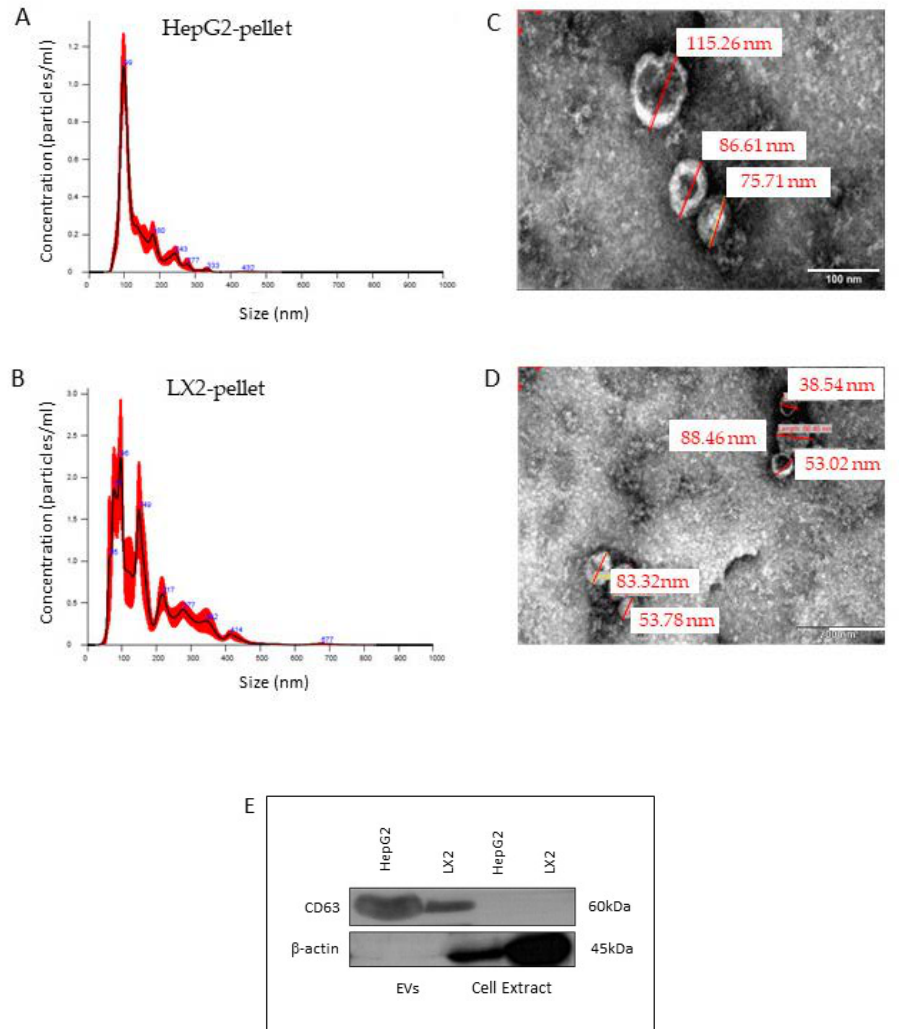
Figure 4. Characterization of LX2- and HepG2-primed medium pellets. Representative nanoparticle tracking analysis (NTA) of size distribution of particles isolated from HepG2- ( A ) and LX2- ( B ) primed medium. Representative transmission electron microscopy image of EVs from HepG2 ( C ) and LX2 ( D ) cultures. Bar = 100 nm. ( E ) The expression of CD63 in the isolated particles was determined by western blotting.